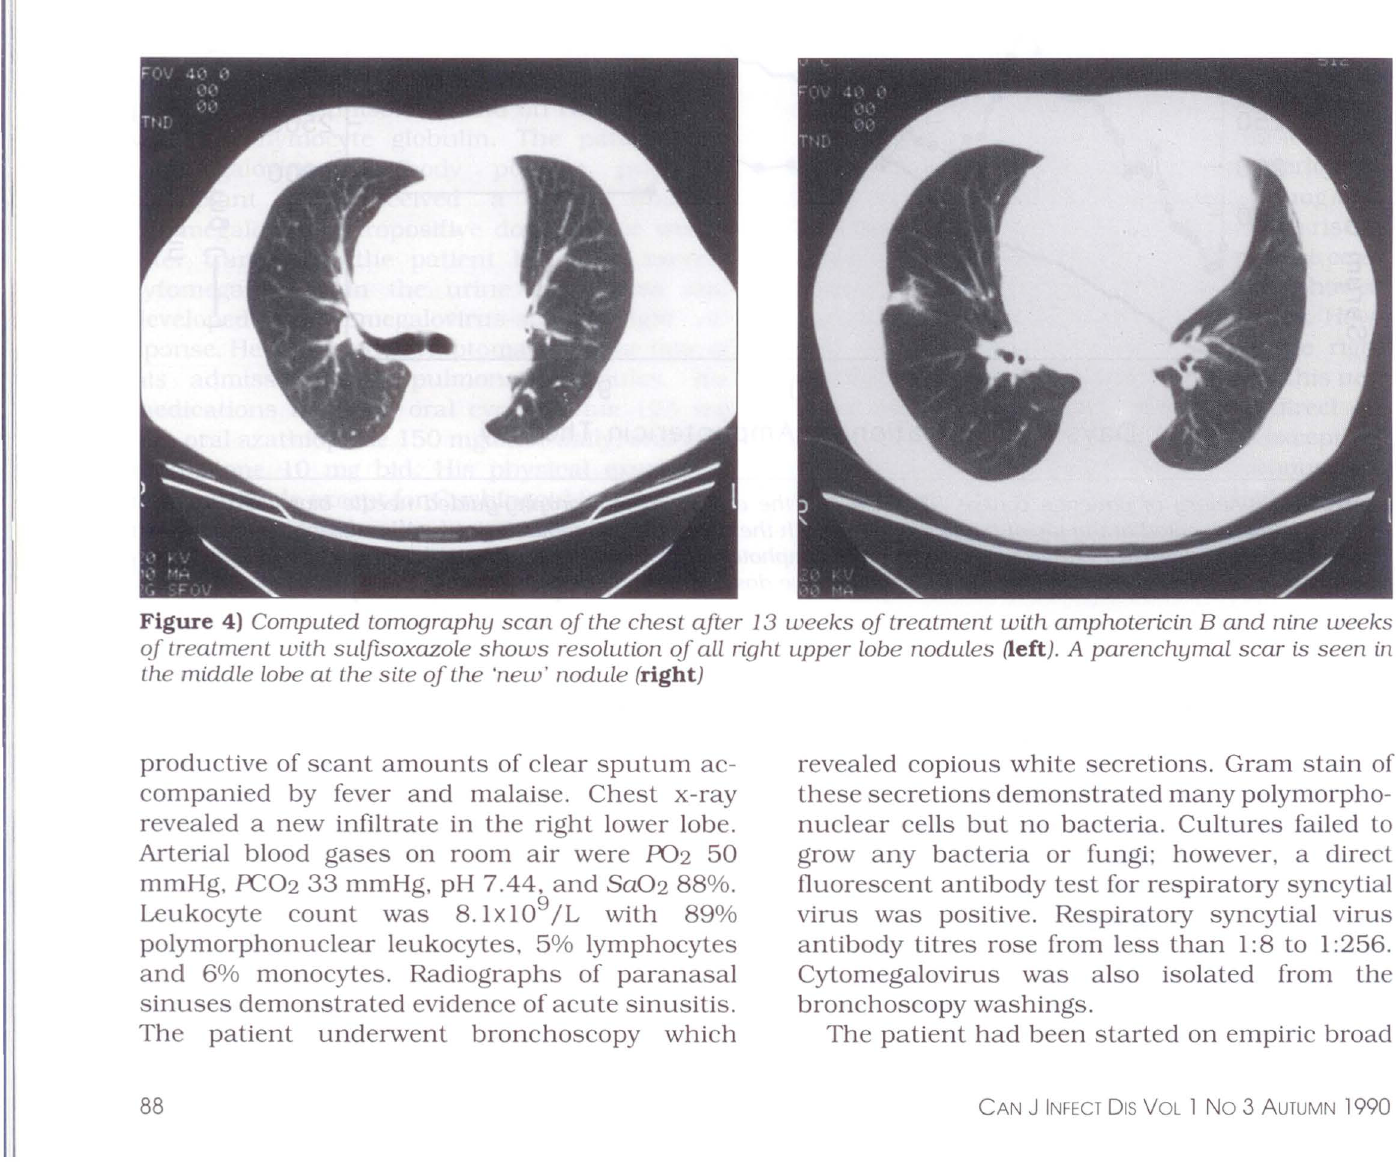
Figure 3) Computed tomography scans of the chest at approximately the same level as seen in Figure 1 following two weeks of treatment with amphotericin B. showing considerable regression in the size of all previously seen nodules (left). An additional nodule. not seen on the initial scans. is seen in the right middle lobe (right). A biopsy of this new nodule revealed Nocardia asteroides